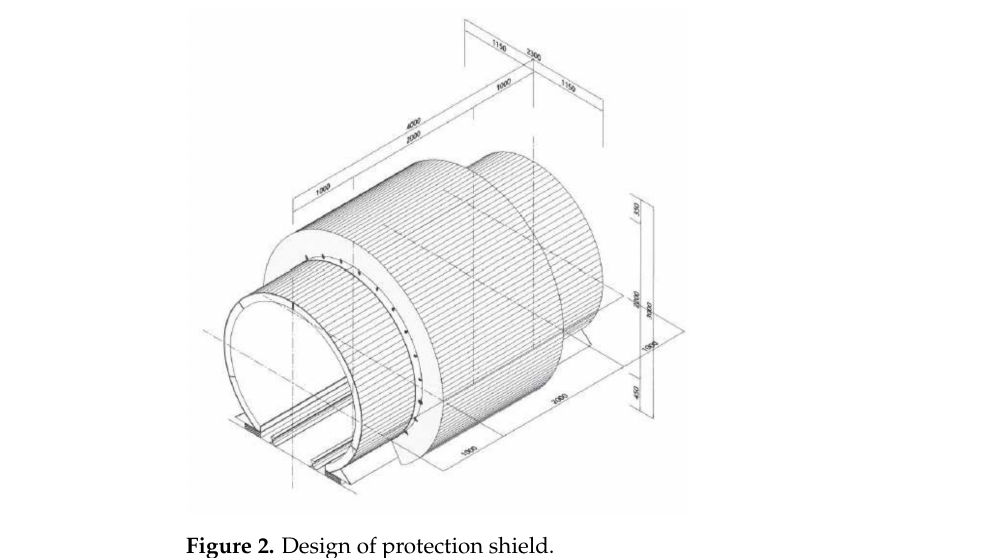
Figure 2. Design of protection shield. Table 2. Material parameters of protection shield. Material Model Steel frame Elastic Inflater